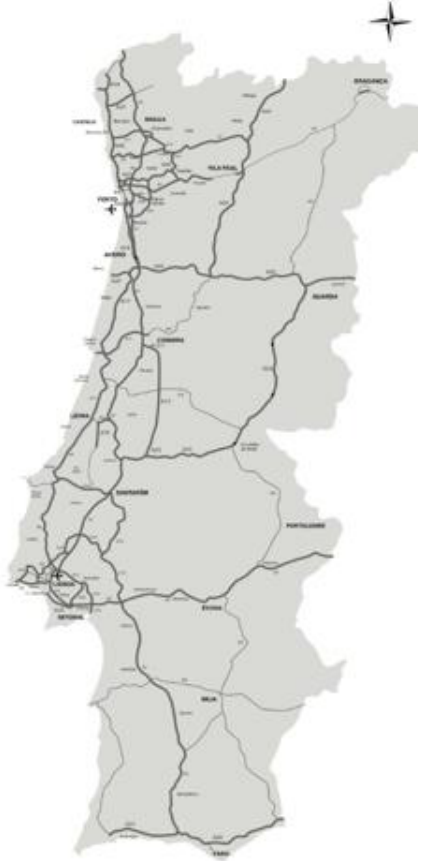
Figure 1 – Portuguese highway network (2017) Source: Portuguese